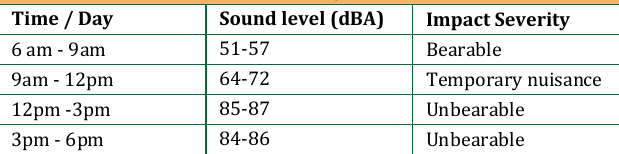
Table 2: Average Noise Level range w.r.t. time range and